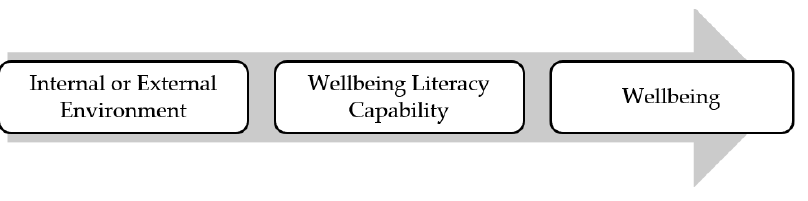
Figure 3. The capability model of wellbeing literacy.